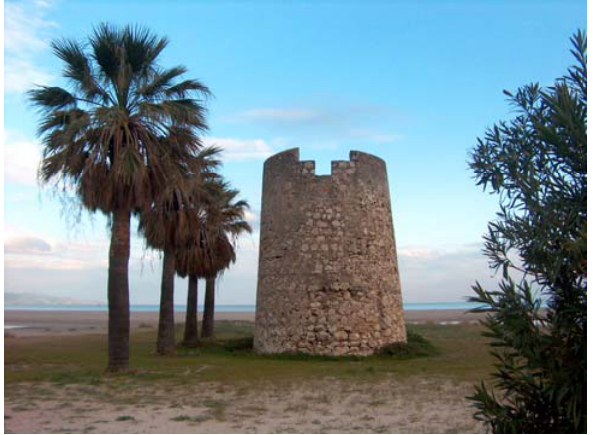
Figure 4: Poetto Coastal Tower